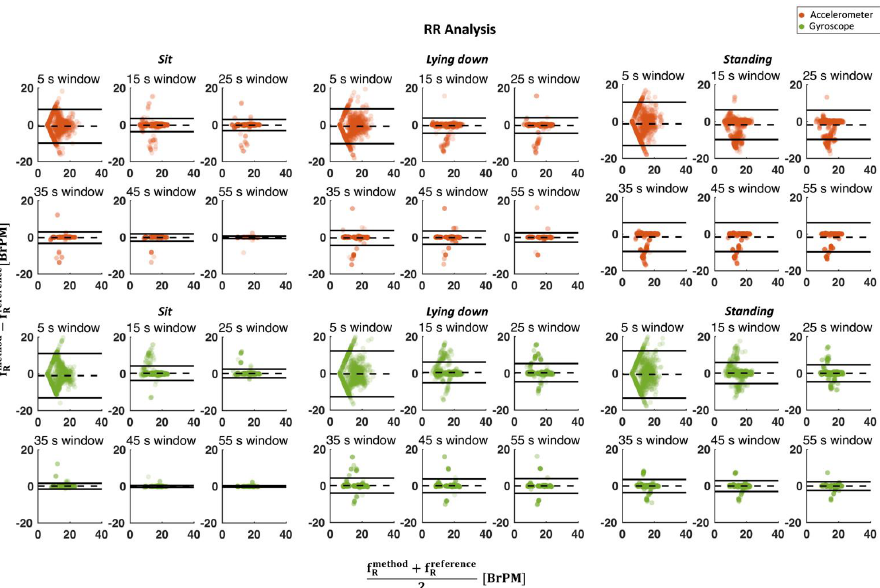
Figure 8. Bland–Altman plot for RR estimation considering all postures from both a (in orange) and ω (in green) signals against reference. The dashed line in the figure represents the MOD while the solid lines represent the LOA values. In each graph, the number of points is equal to the number of subjects multiplied by 120 (i.e., the duration of the test) minus the length of the window.